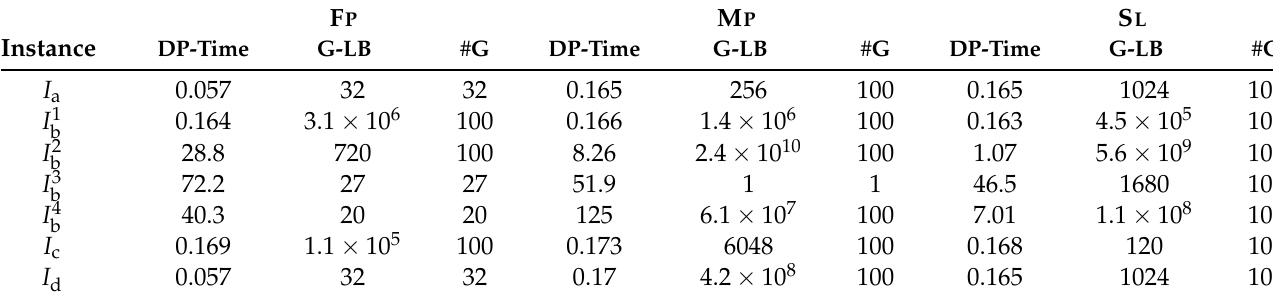
Table 14. Results of Stage 5 for F P , M P , and S L